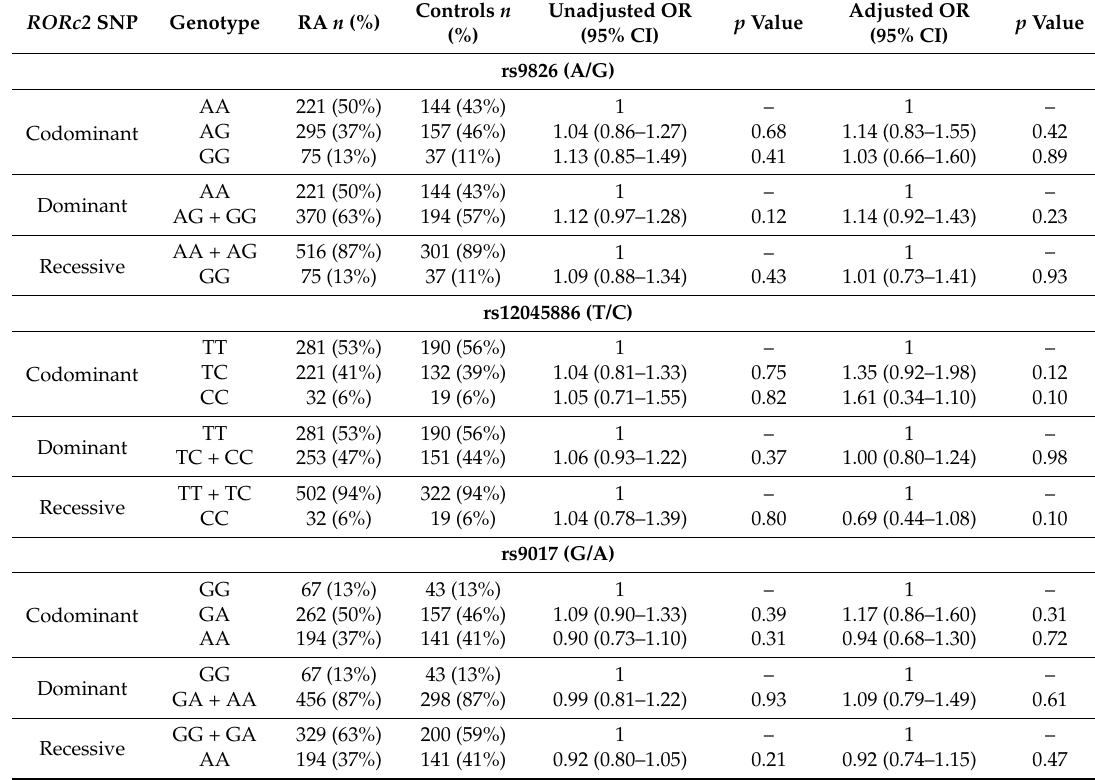
Table 2. Genotype and allele frequencies of the RORc2 polymorphisms in RA patients and controls.